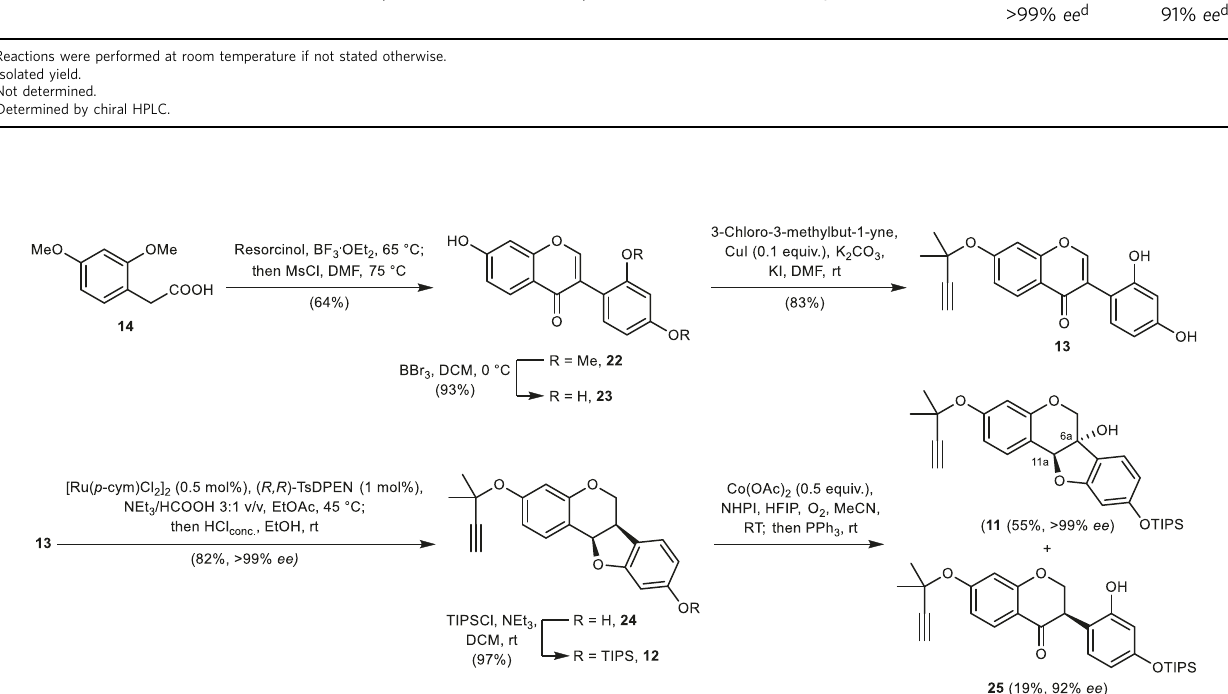
Fig. 5 Application of the ATH in the syntheses of glyceollin I (1) and glyceollin II (2). Iso fl avone 13 was prepared over three steps and subjected to the ATH cascade and subsequent acid-catalysed cyclisation. Benzylic oxidation yielded the 6a-hydroxypterocarpan 11